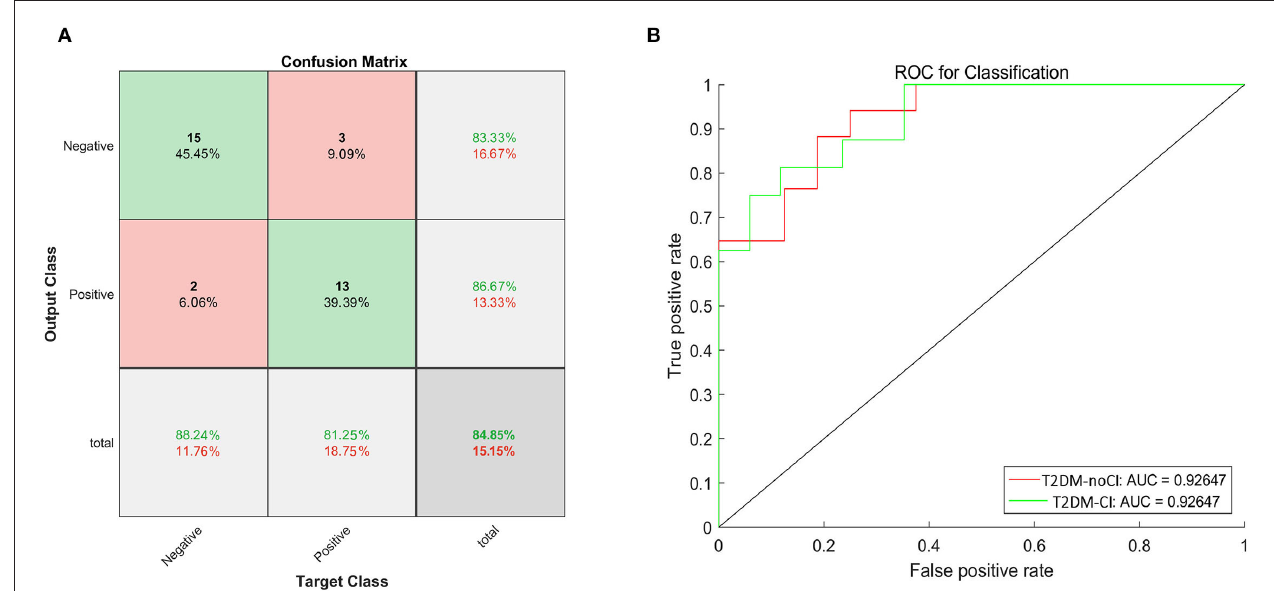
FIGURE 1 | The confusion matrix and the ROC curve of the test dataset. (A) The green boxes represent the true negative and positive rates, and the red boxes represent the false negative and positive rates. The dark gray boxes in the lower right corner represent the accuracy. The accuracy was 84.85%. (B) The ROC curve to classify cognition, the red line represented the ROC of T2DM-noCI, and the green line represented the ROC of T2DM-CI. The AUC was